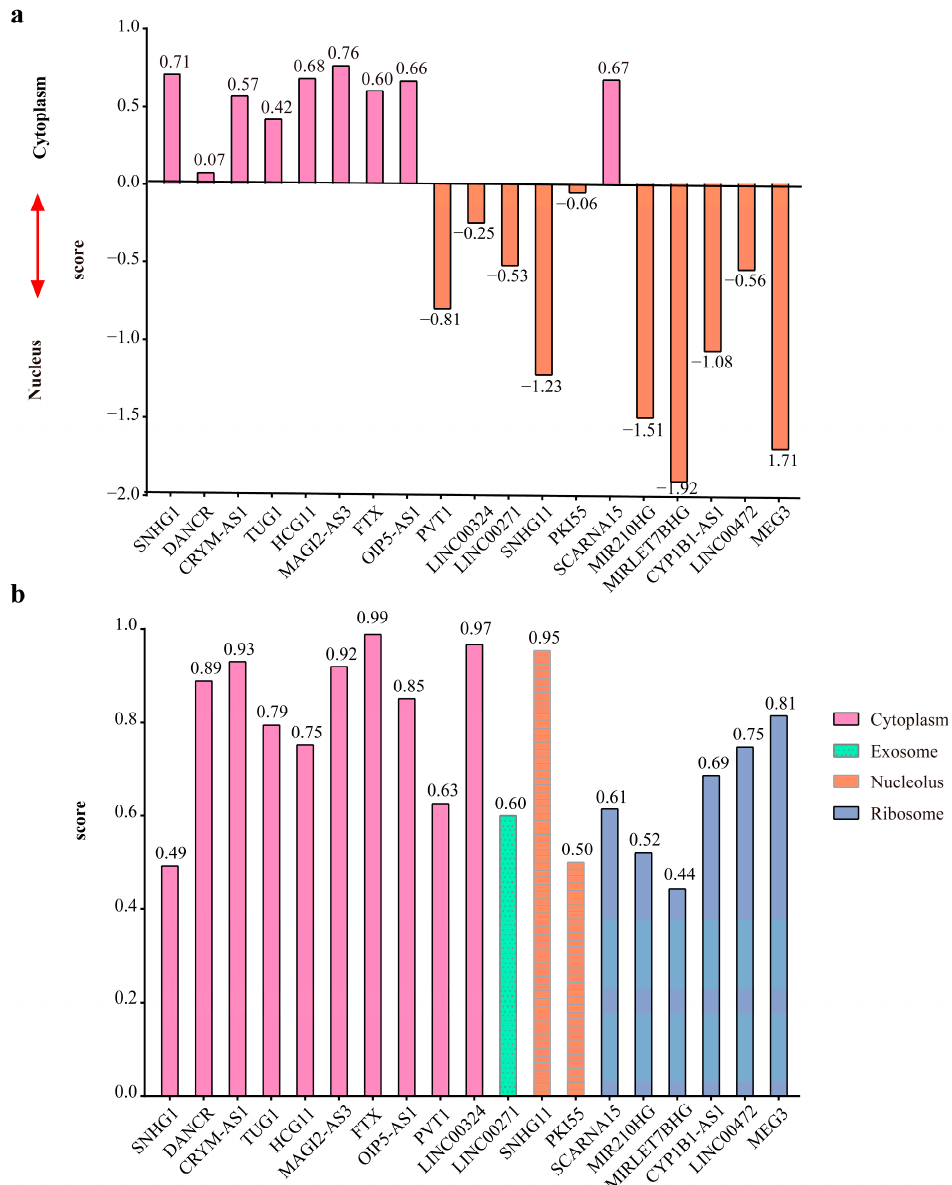
Figure 10. Subcellular localization of lncRNAs: ( a ) Subcellular localization of lncRNAs in hub-FFL network predicted in lncLocator based on deep learning of A549 cell line data; ( b ) Subcellular localization of lncRNAs in hub-FFL network predicted in iLoc-lncRNA.